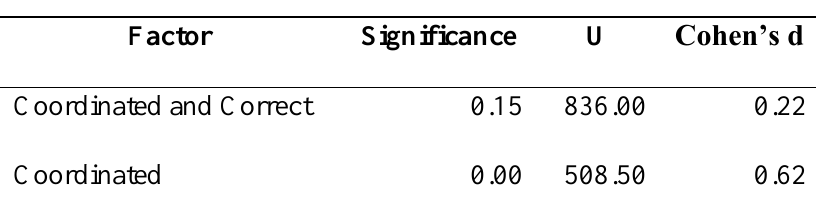
Table 12.4 – Actual vs Random dyad